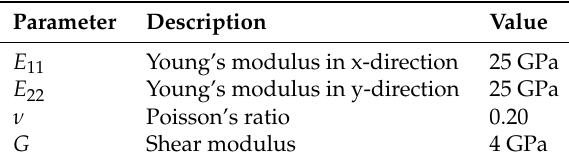
Table 1. Fiberglass fabric mechanical properties.